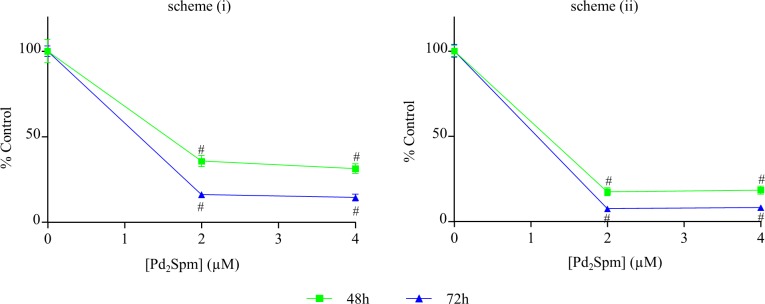
Antiproliferative assays for the MDA-MB-231 cell line upon exposure to Pd2Spm/DTX combination.Simple proliferation of MDA-MB-231 cells simultaneously exposed to: (A) 1x10-2 μM of DTX, and 2 or 4 μM of Pd2Spm (scheme(i)); (B) initially exposed to DTX (1x10-2 μM) for 24 hours, and then to Pd2Spm (2 or 4 μM) (scheme (ii)). The results are expressed as a percentage of the control ± SEM as a function of Pd2Spm concentration (since DTX concentration was the same across all experiments, 1x10-2 μM). The one-way ANOVA statistical analysis was used, and the Dunnett’s post-test was carried out to verify the significance of the obtained results (*p<0.05, **p<0.01, ***p<0.001, #p<0.0001 versus the control, for the same time-points).